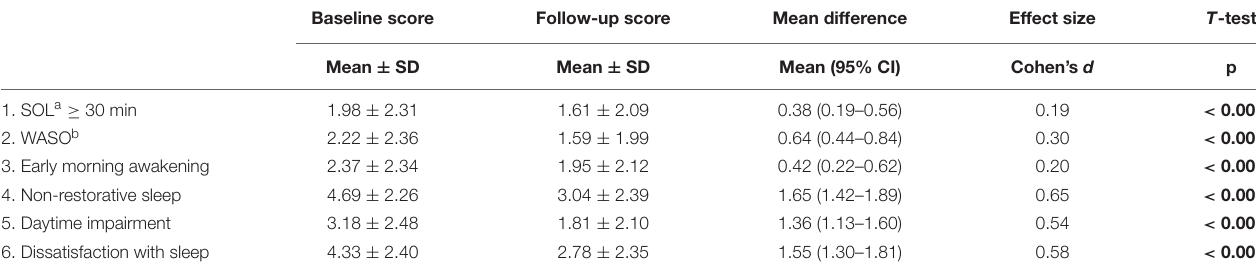
TABLE 2 | Comparison of item 1–6 in BIS among 442 Norwegian patients with obstructive sleep apnea at baseline and follow-up (with CPAP). Baseline score Follow-up score Mean difference